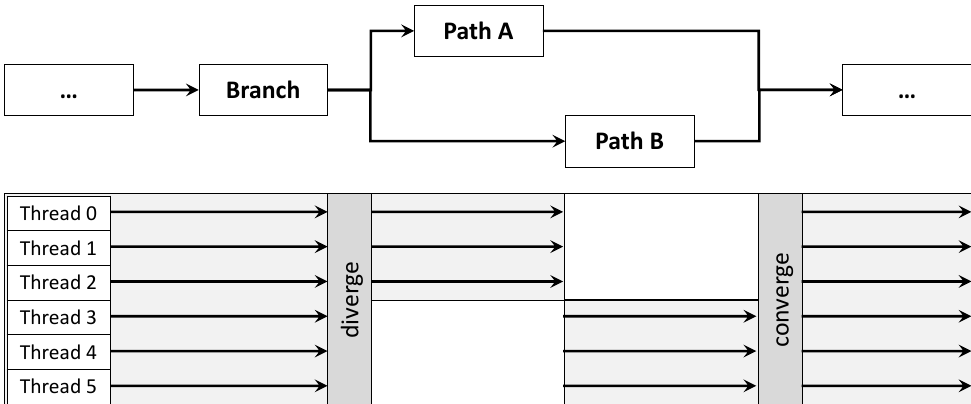
Figure 4. Bank conflict conditions.